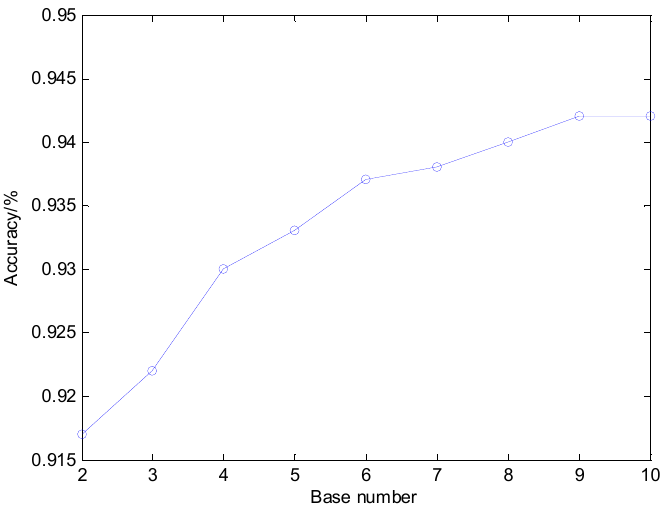
Figure 9. The classification result of shift invariant sparse feature with different K .